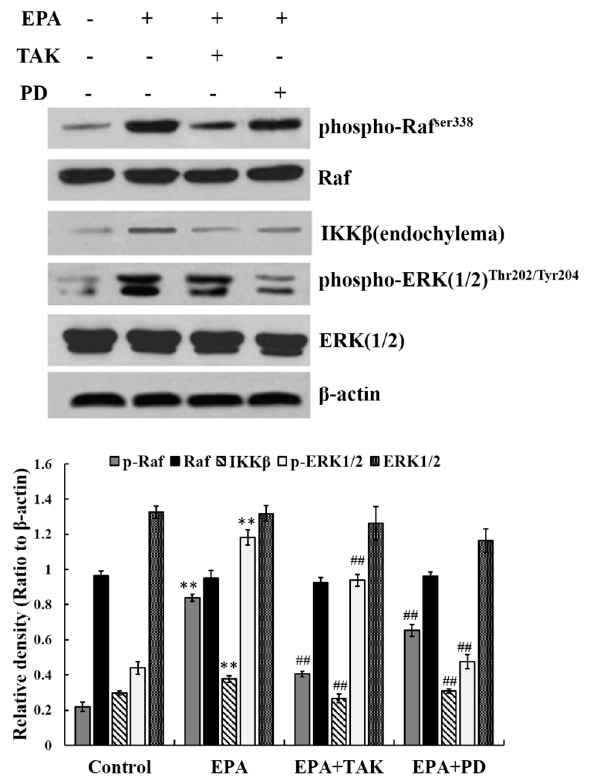
Figure 4. The relationship among ERK1/2, Raf and IKK β . C ells were treated with DMSO (equivalent volume 3.0 μ M EPA, as conrtrol) or 2.4 μ molof EPA for 24 h in the presence or absence of 10 μ mol PD or 25 nmol TAK. The expression of protein was analyzed by Western blot. The β -actin was used as an equal loading control. Each bar is representative of 6 independent experiments, and data were analyzed by ANOVA and Duncan’s multiple range tests (means ± SD, ** p < 0.01 compared with the